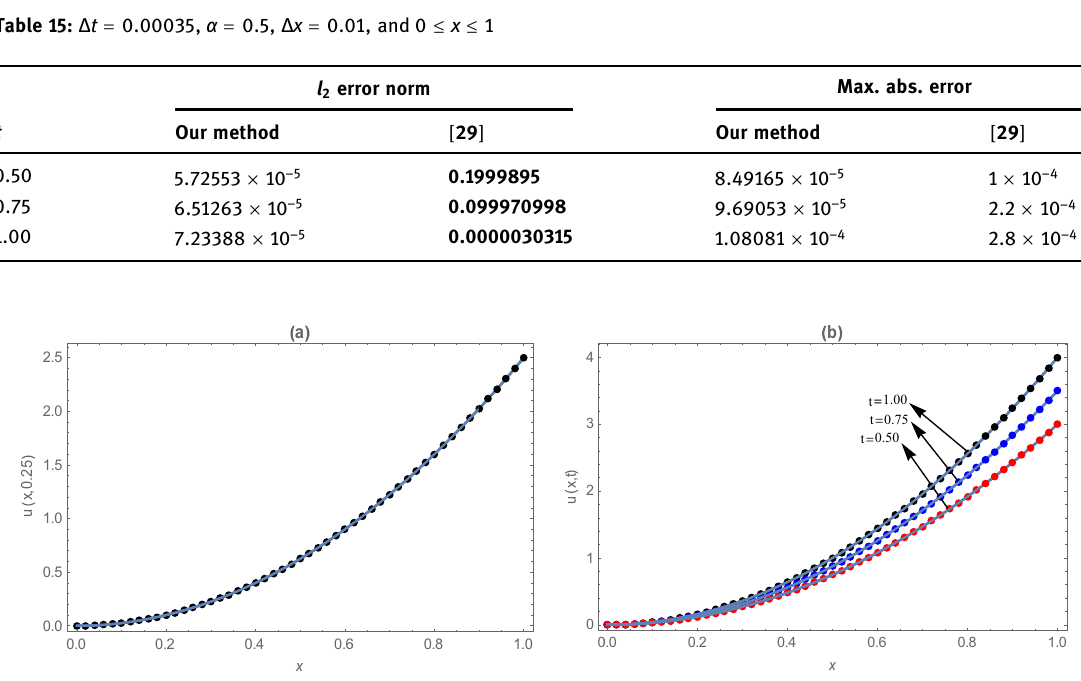
Figure 5: Graphs of approximate and exact solutions for ( a ) t 0.25 =